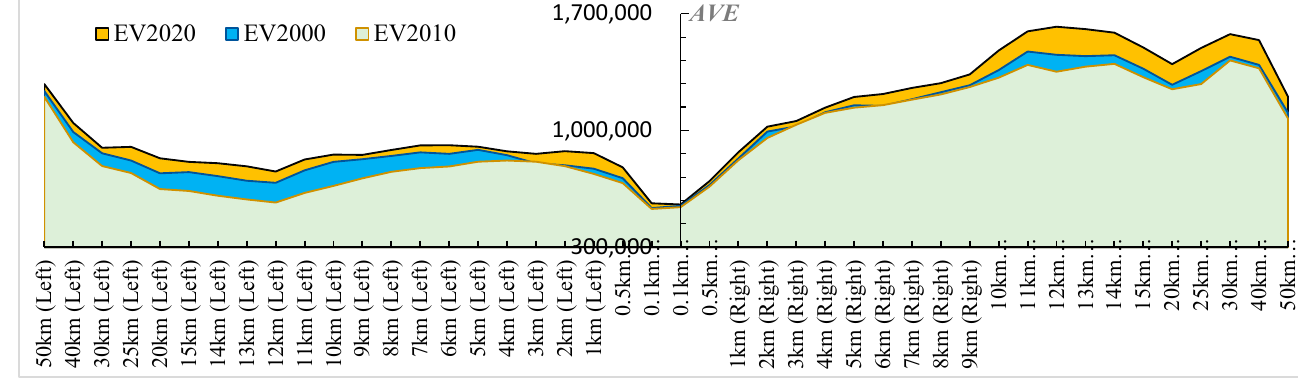
Figure 6. AEV of different buffers on the left and right sides along the QTR.